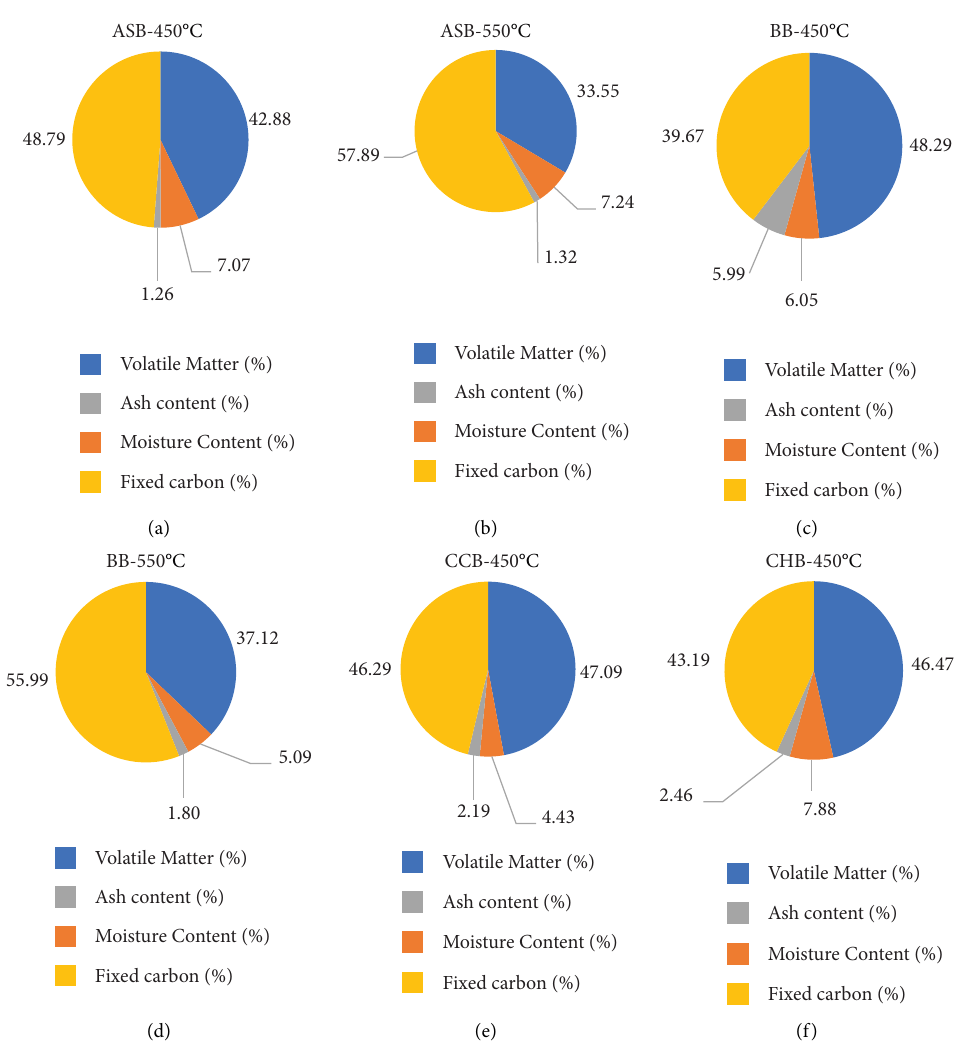
Figure 5: Proximate analysis of biochars. (a) Avocado seed biochar pyrolyzed at 450 ° C. (b) Avocado seed biochar pyrolyzed at 550 ° C. (c) Bamboo biochar pyrolyzed at 450 ° C. (d) Bamboo biochar pyrolyzed at 550 ° C. (e) Corncob biochar pyrolyzed at 450 ° C. (f) Cofee husk biochar pyrolyzed at 450 °